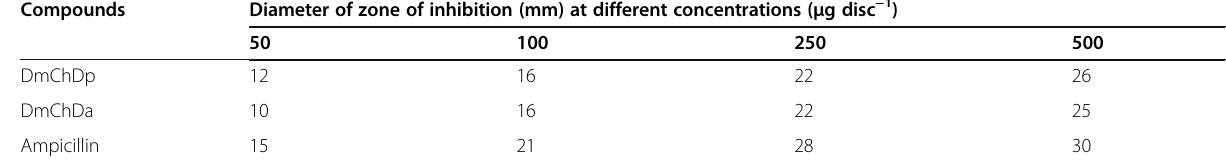
Table 1 Antibacterial activity of the Schiff bases and ampicillin Compounds